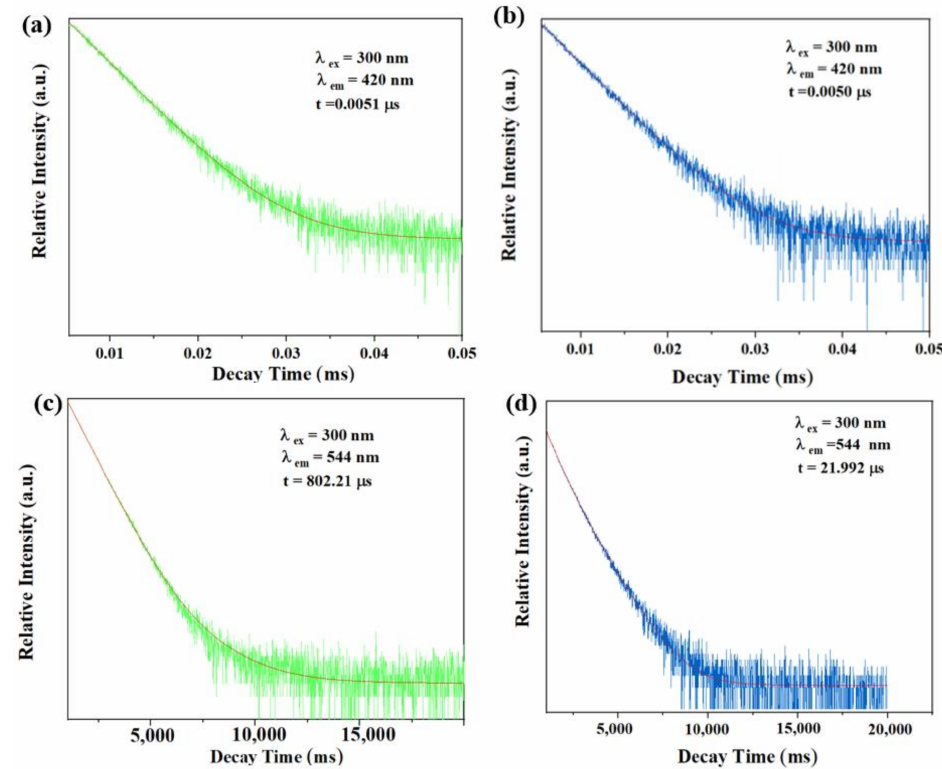
Figure 8. The fluorescence lifetime of the sample at 420 nm in the absence ( a ) and presence ( b ) of TDGA; The fluorescence lifetime of the sample at 544 nm in the absence ( c ) and presence ( d ) of